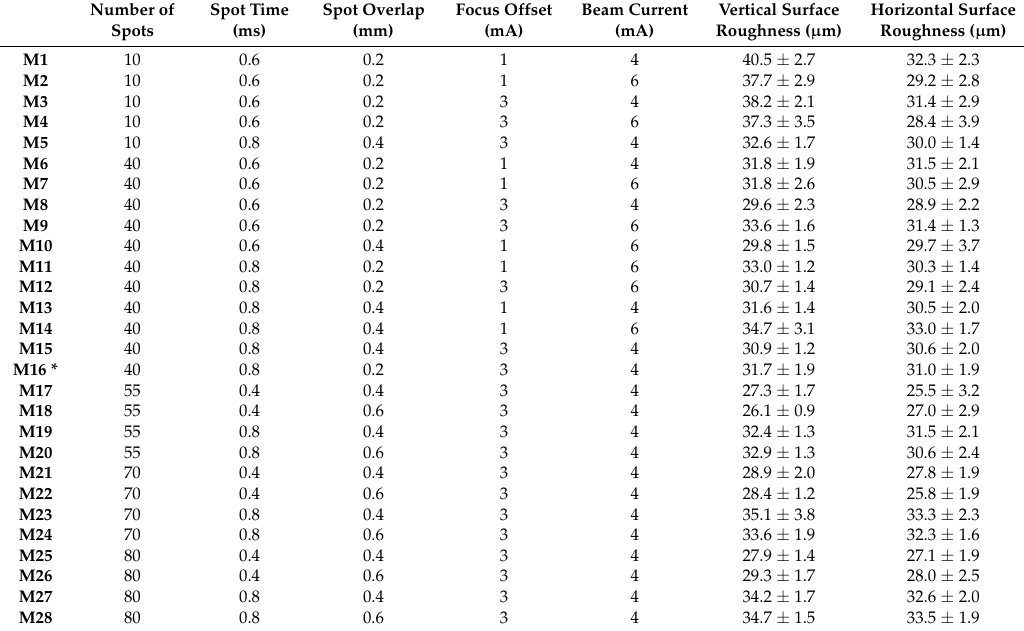
Table 2. Surface roughness results of multispot contouring. All the average values and standard deviations were obtained by measuring at least five